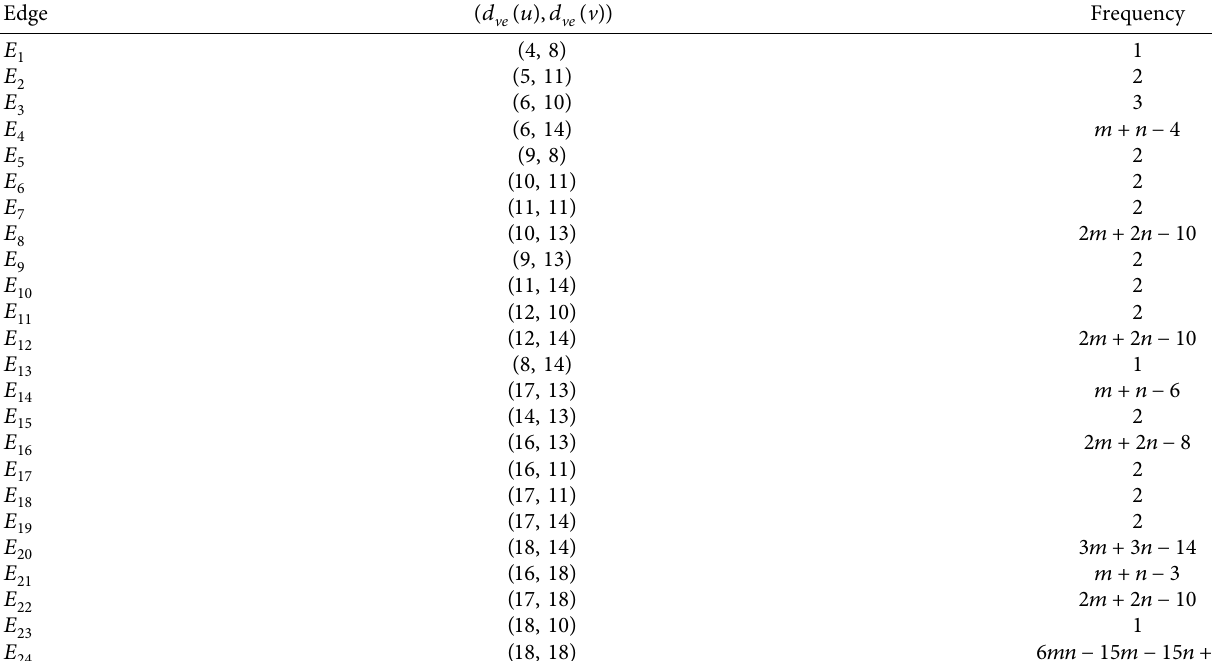
Table 3: Edge Partition of vanadium